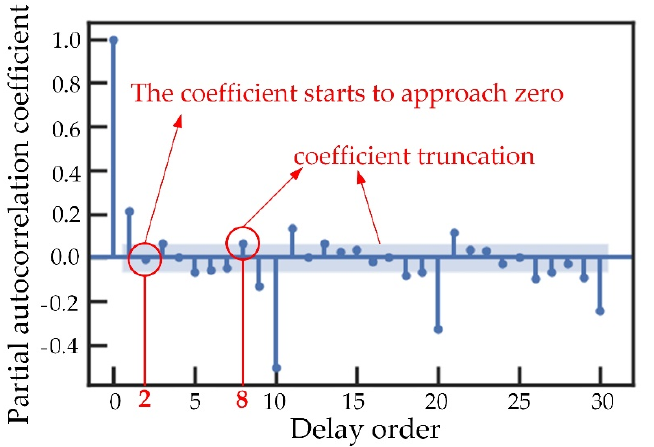
Figure 8. The partial autocorrelation diagram of the second-order difference series of downstream traffic.